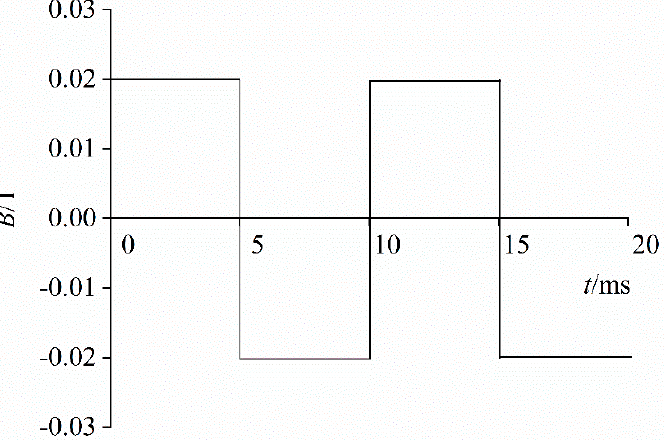
Figure 2. Magnetic flux density waveform of 100 Hz external axial magnetic field (EAMF).